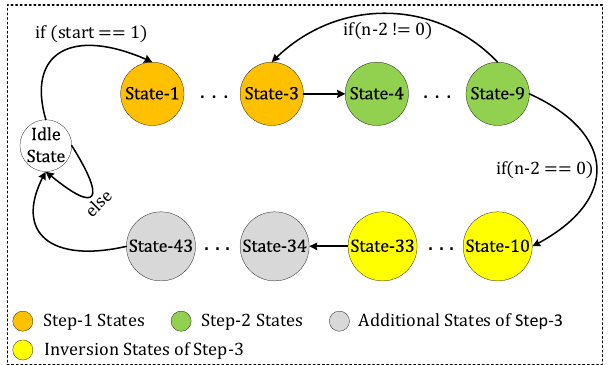
Figure 3. Control unit of the proposed architecture for GF ( 2 571 )